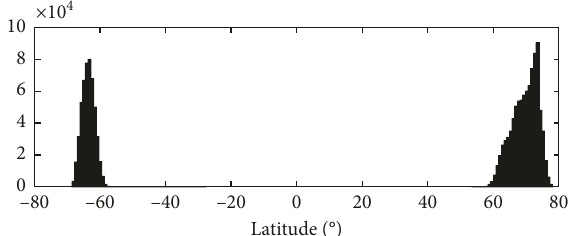
Figure 6: Number distribution of collocated data between OSCAT and ASCAT on the latitude.